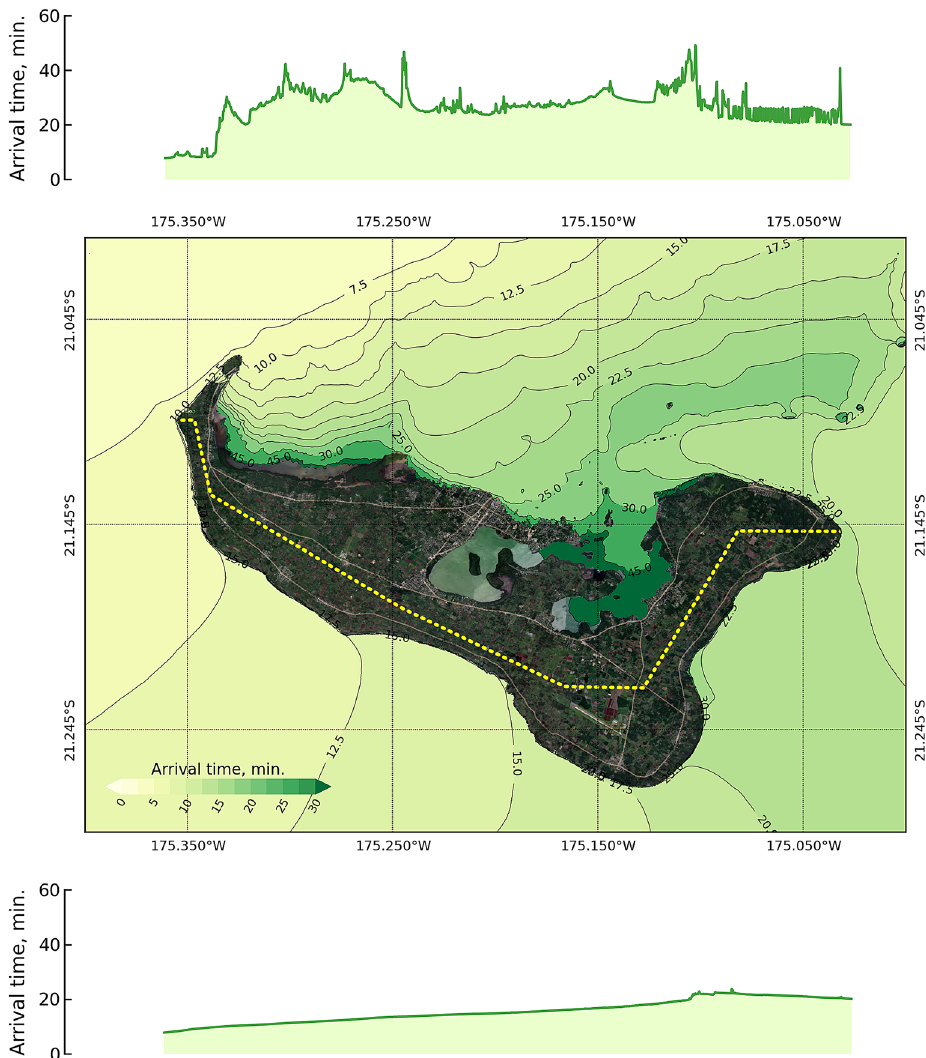
Figure 7. Arrival time of the tsunami around Tongatapu after 3 hours of simulation for the 25 Mt explosion source at the HTHH volcano on the deep sea depth condition. The middle panel shows the spatial distribution of the arrival time. The top panel shows the arrival time at the coastline to the north of the island, and the lower panel shows the arrival time to the south. The map was created with a QGIS software 11 , version 3.16.15-Hannover (http:// www. qgis. org), and the satellite image for basemap was downloaded from QuickMapServices plugin (https:// github. com/ nextg is/ quick mapse rvices) through the QGIS 11